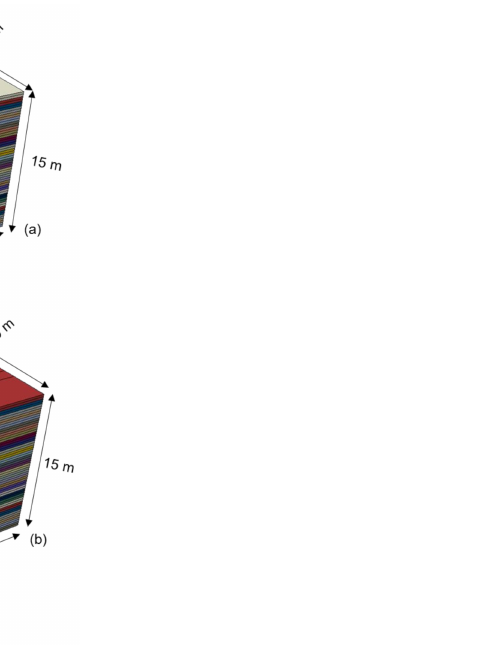
Figure 1. Finite element (FE) model for the 5 × 5 pile group: ( a ) free-head and ( b ) fixed-head